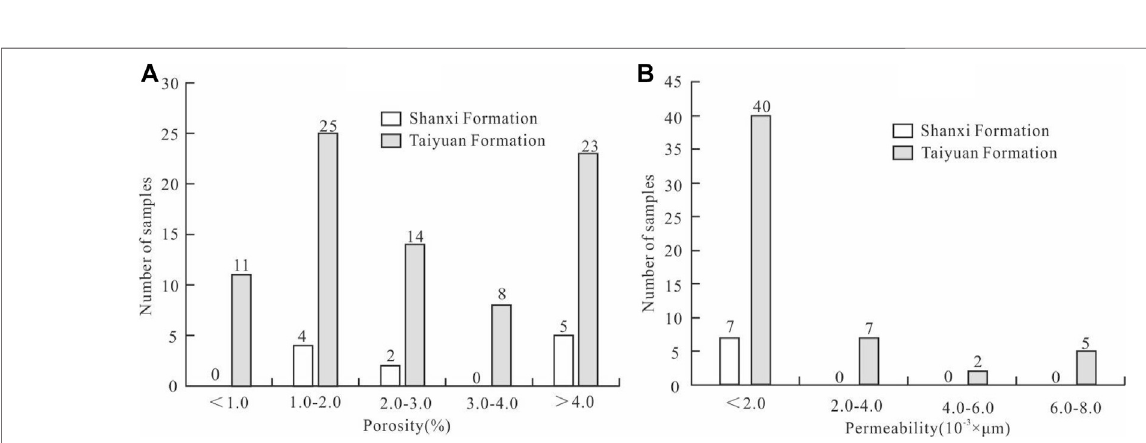
Frontiers in Earth Science |